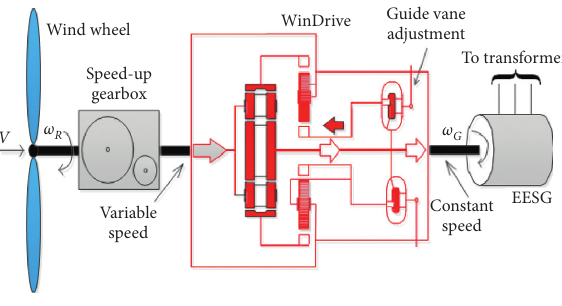
Figure 2: Structure of the FSCWT.